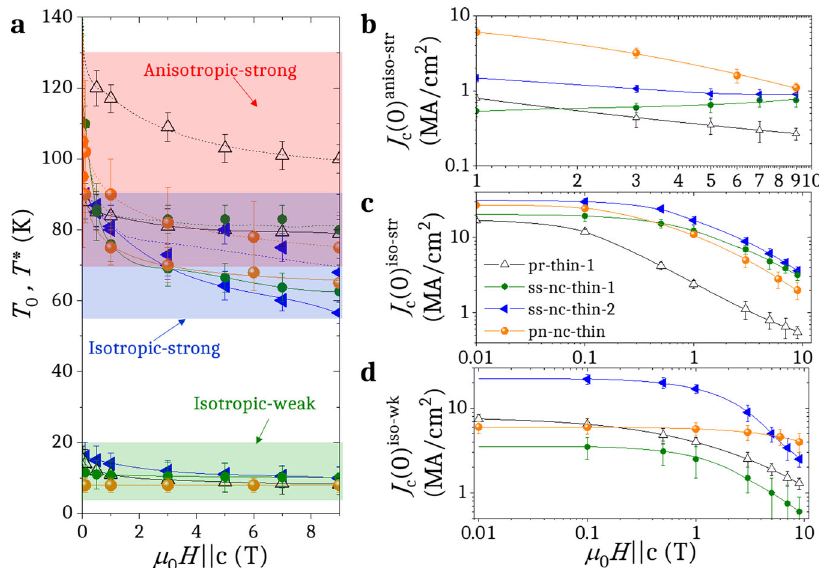
Fig. 5 Characteristic temperatures, density and strength of pinning centres for H | | c. Applied magnetic fi eld dependence of characteristic temperatures ( a ) T 0 (solid lines, green region), T * iso-str (solid lines, blue region) and T * aniso-str (dashed lines, red region), and J c contributions at 0 K ( b ) J c (0) aniso-str , ( c ) J iso-str and ( d ) J iso-wk for pr-thin-1, ss-nc-thin-1, ss-nc-thin-2 and pn-nc-thin samples for H | | c. Error bars are determined by the standard error of c (0) c (0) the parameters from the fi tting of Eq.